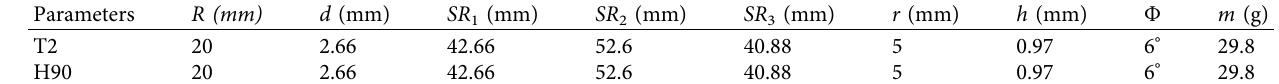
Table 1: Structural parameters (T2 copper liners and H90 brass liners).